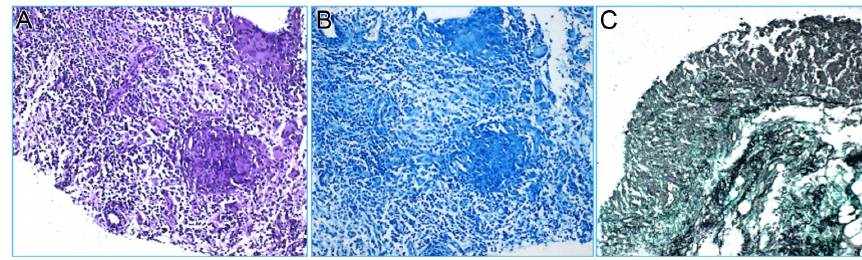
Figure 5. A-C. Non-necrotizing granulomas were negative for Periodic acid–Schiff (PAS) (A and B), Ziehl-Neelsen (EZN), and Grocott